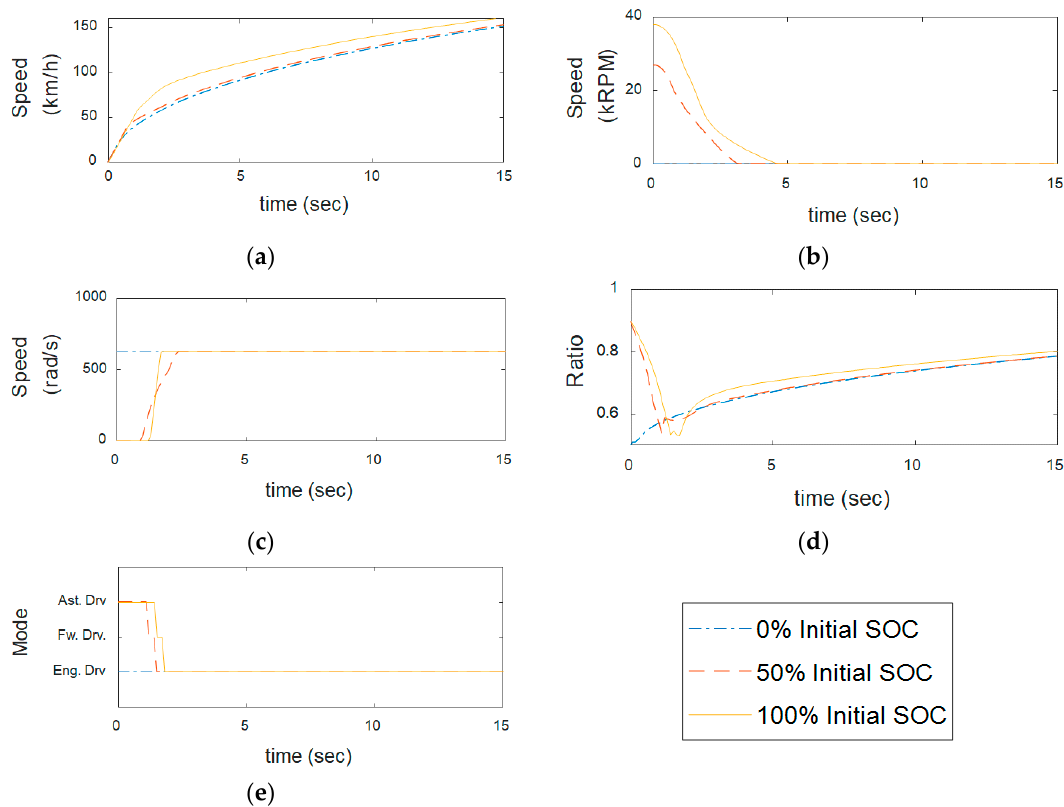
Figure 16. Acceleration simulation result plot at 0%, 50%, and 100% initial SOC: ( a ) vehicle speed profile; ( b ) flywheel speed profile; ( c ) engine speed profile; ( d ) CVT Ratio Profile; and ( e ) driving mode profile.